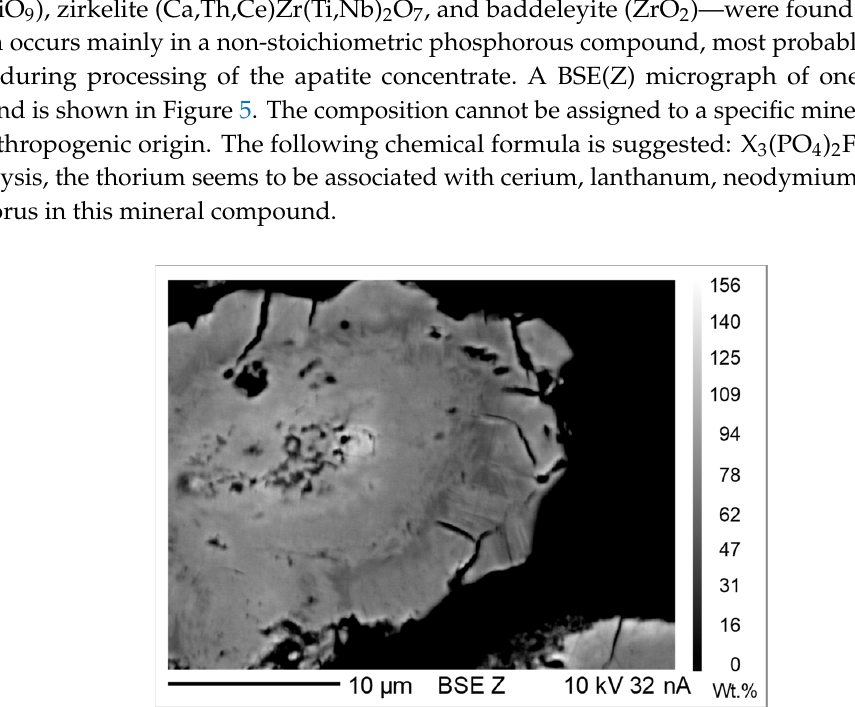
100 Figure 6. Yields of elements after digestion with concentrated sulfuric acid at different temperatures and times. In all experiments, the ratio of concentrated sulfuric acid to rare earth oxide (REO) was 5. After digestion, the cake was leached with water at a solid:liquid (S:L) ratio of 10 for 1 h at room temperature. In all experiments, a high extraction of REEs was achieved. As expected, a decrease was observed at 600 °C due to partial incorporation of the REEs into pyrophosphate residue (see Section 2.3). Depending on the conditions, phosphorus and thorium were either leached (250 °C) or mostly 02040 6080 La Ce Nd Ca Fe P Si Sr Ti Nb Th Zr Y i e l d i n % Elements A: single-stage 250 °C for 4 h B: single-stage 600 °C for 4 h C: two-stage 250 °C for 2 h, 600 °C for 2 h